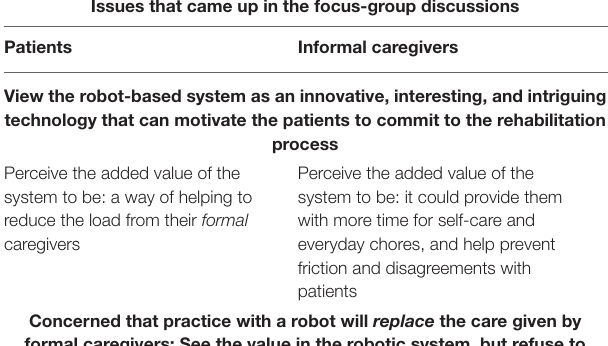
TABLE 4 | The main similarities and differences between the two population